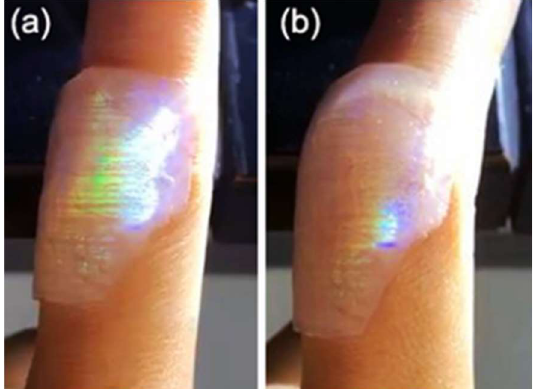
Figure 9. The picture of the SF-PNIPAM dual-crosslinked nanocomposite film attached to the knuckle surface ( a ) past on finger joints; ( b ) bent to 160°.